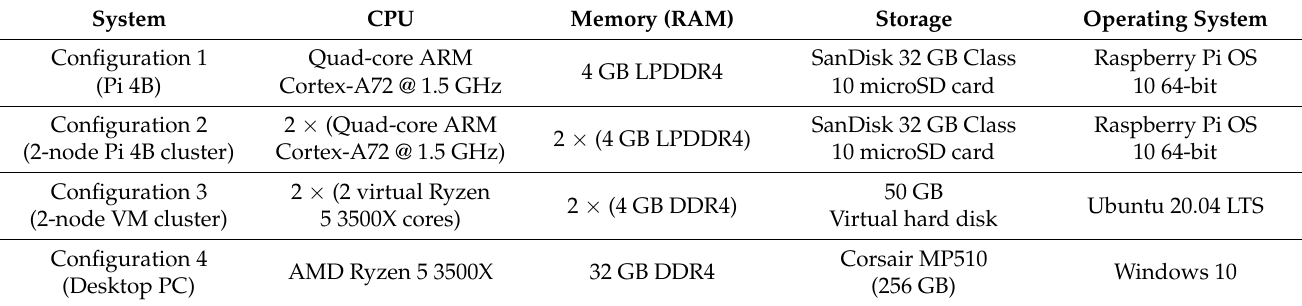
Table 4. Systems used in the